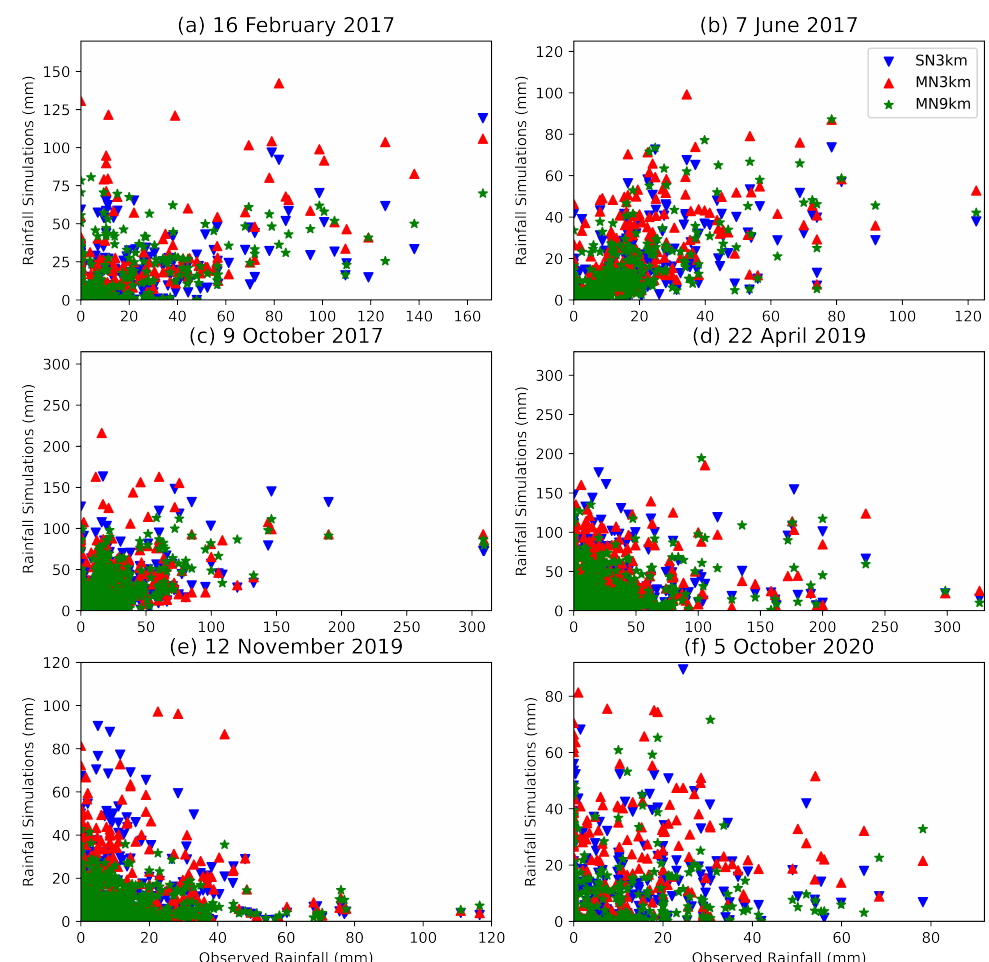
Figure 8. The observation and CCAM simulations scatter plot for ( a ) tropical cyclone Dineo, ( b ) the Cape storm, ( c ) the KZN 2017 October floods, ( d ) the KZN 2019 April floods, ( e ) the KZN 2019 tornadoes and ( f ) the Johannesburg